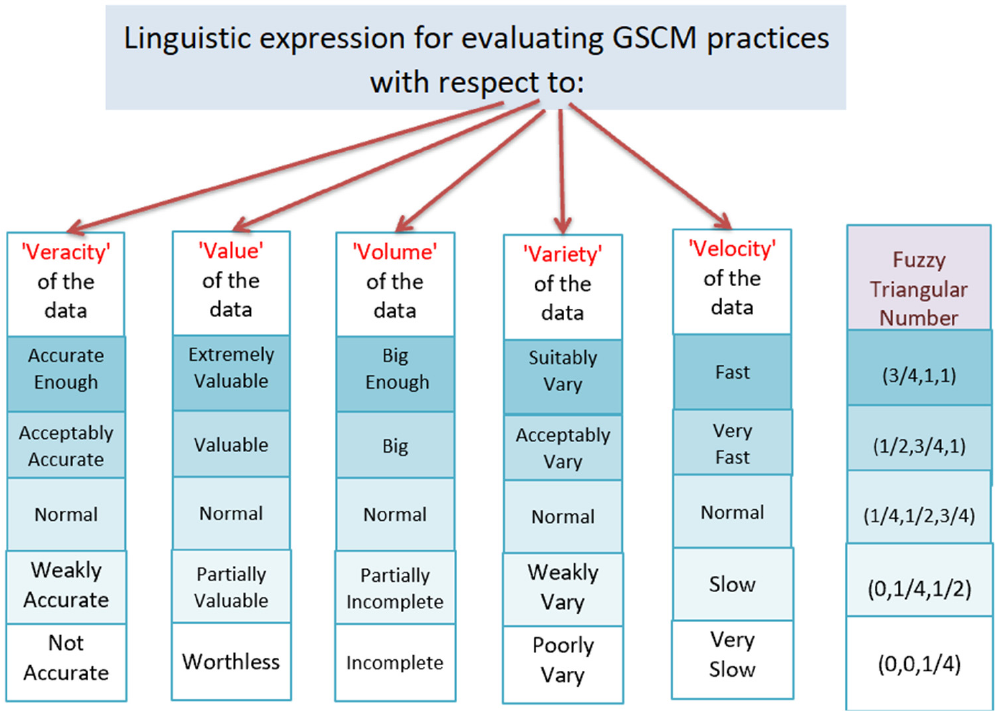
Figure 4. Fuzzy TOPSIS linguistic scale.